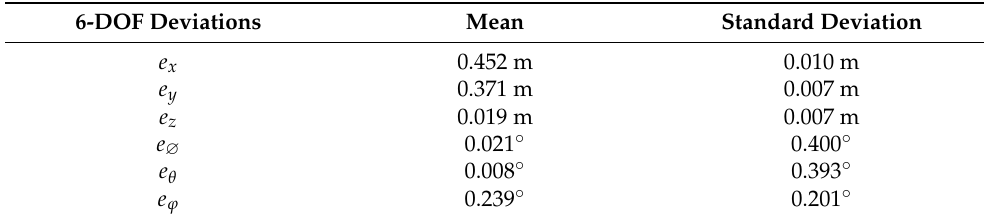
Table 1. Statistics of 6 degrees of freedom deviations from 1500 sets of rendezvous and docking results of spacecraft dynamics